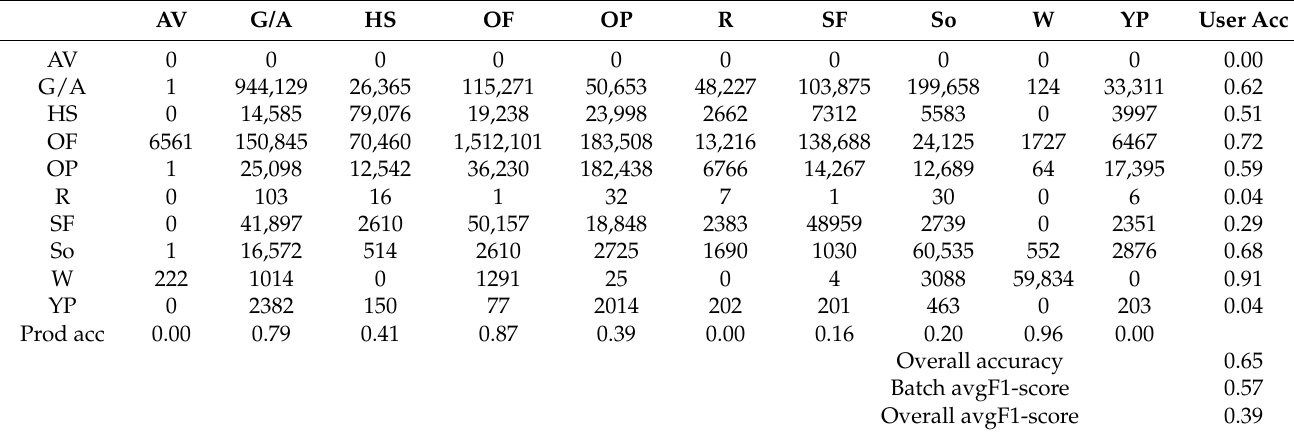
Table A3. Confusion matrix for the validation set using the SAR U-net. Rows show predicted classes while column, ground truth classes. LULC abbreviations: AV, aquatic vegetation; G/A, grasslands/agriculture; HS, human settlements; OF, old-growth forests; OP, old-growth plantations; R, roads; SF, secondary forest; So, soil, W, water; YP, young plantations. User acc stands for user’s accuracy, while Prod acc for producer’s accuracy.